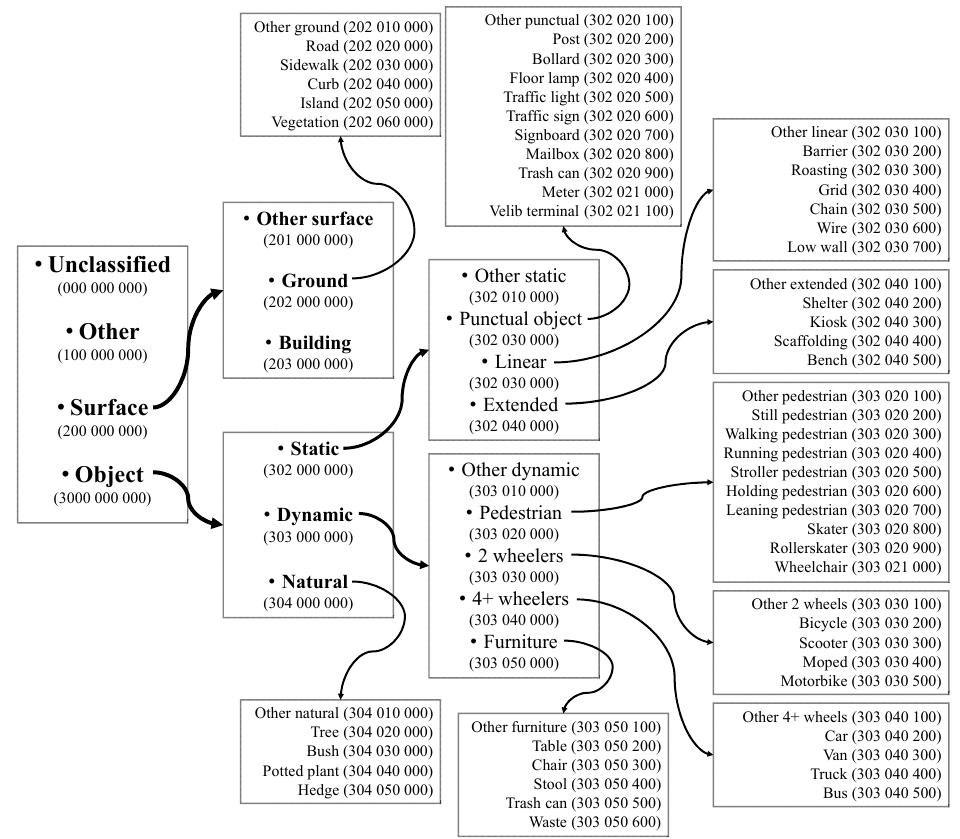
Figure 9. An example of the class tree used in Paris-rue-Madame, iQmulus, and Paris-Lille-3D datasets